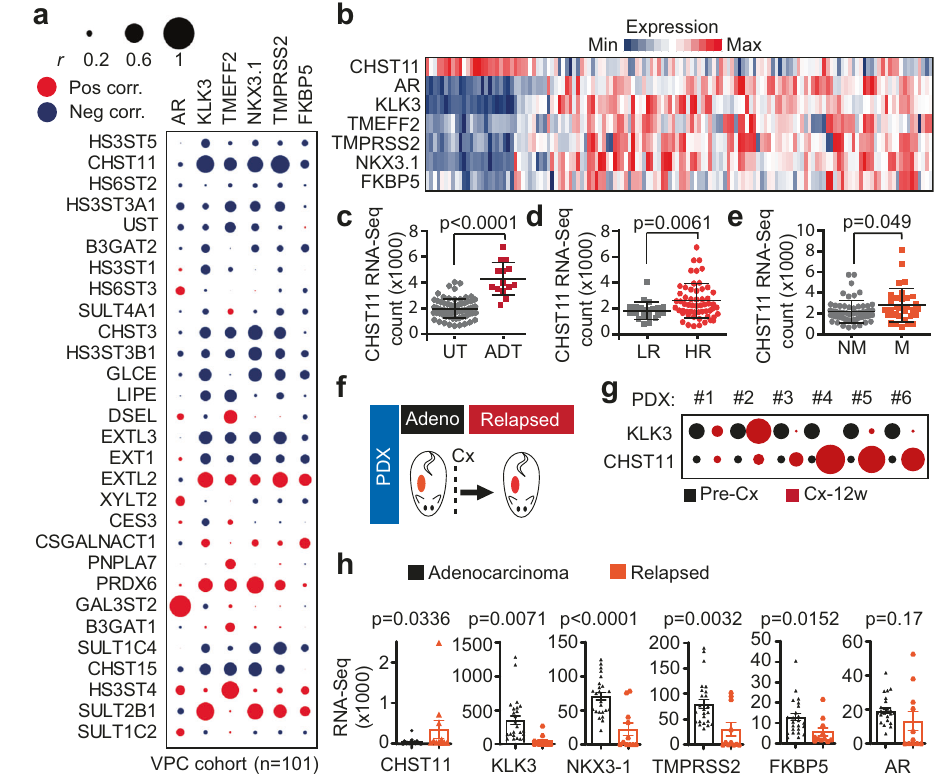
Fig. 2 | Patient tumors with loss of AR activity display elevated CHST11 and chondroitin sulfate levels. a Correlation analysis of mRNA levels of GAGs bio- synthesis genesidenti fi edinFig.1cand ARregulated genes ( KLK3,TMEFF2,NKX3.1, TMPRSS2, FKBP5 ). Circle size represents Pearson correlation coef fi cient absolute values. Blue, negative correlation; Red, positive correlation, VPC cohort ( n =101) 39 . b HeatmapofgeneexpressioninCRPCpatients;(UWcohort; n =138)[https://www. ncbi.nlm.nih.gov/geo/query/acc.cgi?acc=GSE147250] (GSE147250). c CHST11 gene expression in untreated ( n =69) and ADT treated PC patients ( n =14) (mean±SD; two-tailed Mann-Whitney test); d low-risk (LR, n =22) and high-risk (HR, n =57)